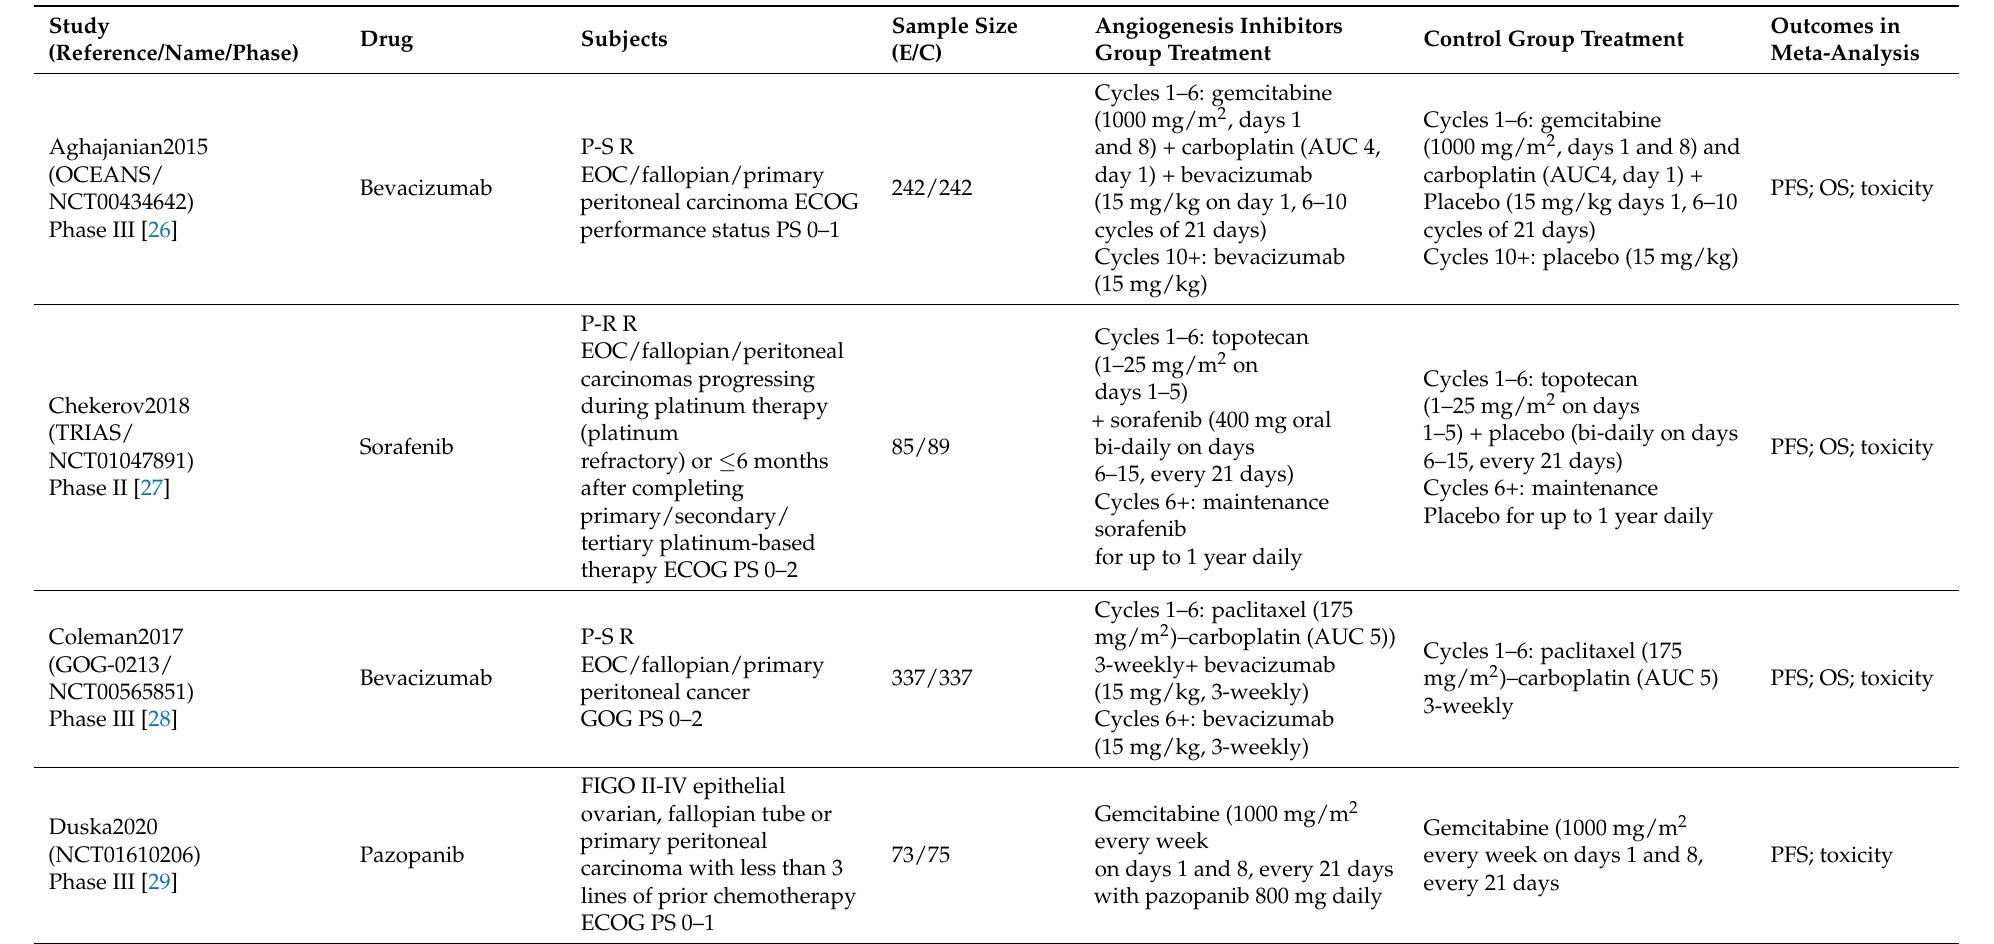
Table 2. General characteristics of RCTs